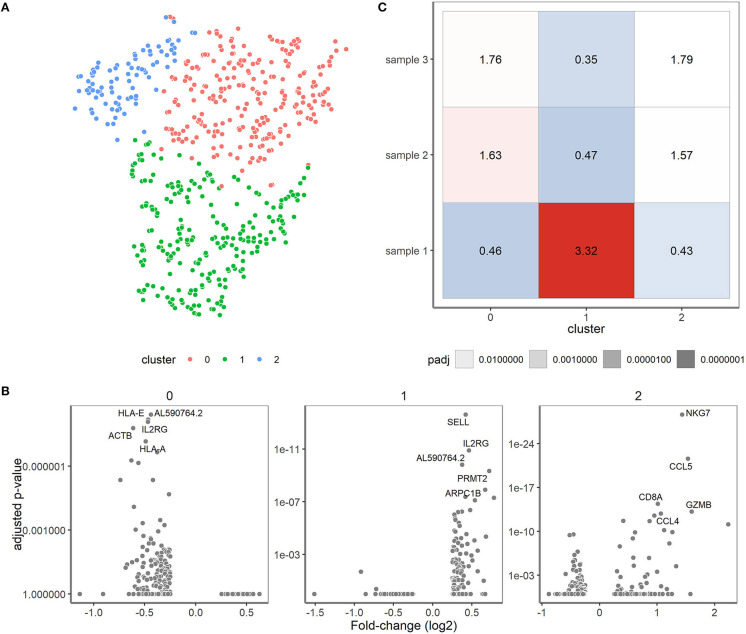
Single-cell transcriptomics reveals three cell type-specific clusters for the clinical samples. (A) t-SNE visualization showing the clusters. Cluster 0 represents cells mainly negative for CD4 and CD8 (depicted in red), cluster 1 predominantly consists of CD4+ T cells (depicted in green) and cluster 2 that of CD8+ T cells (depicted in blue). (B) Differential expression analysis of the cells in the cluster vs. the cells outside of the cluster. The fold changes (X-axis) and adjusted P-values (y-axis) are depicted for the genes and top 5 marker genes per cluster are shown. (C) Over-/underrepresentation of each of the clinical samples is depicted for the three clusters.